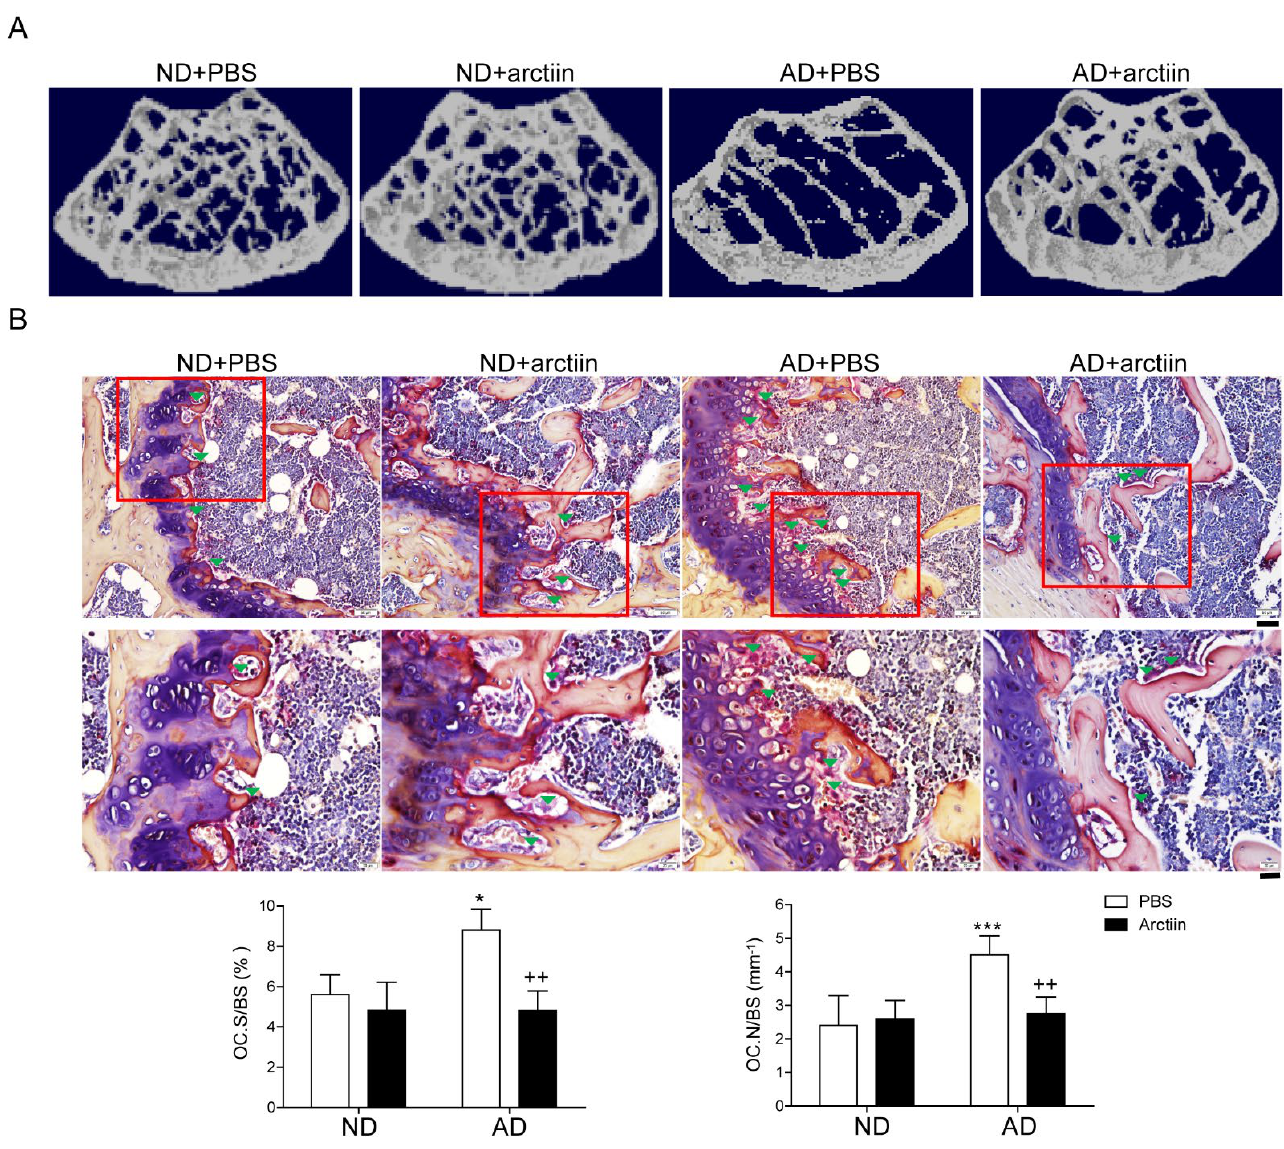
Figure 1. Arctiin protects mice from atherogenic diet-induced bone loss. ( A ) Representative µ CT images of distal mouse femora area (1.7 mm) located 0.4 mm below the distal femur growth plate in mice fed with ND + PBS ( n = 5), ND + arctiin (10 mg/kg/d, n = 5), AD + PBS ( n = 5), or AD + arctiin (10 mg/kg/d, n = 5) for 6 weeks. ( B ) Representative histologic sections of the distal femoral metaphysis of each group were stained for TRAP to calculate the OC.N/BS (OC number over total bone surface) and OC.S/BS (OC surface over total bone surface) ratios (original magnification × 200 (top) and × 400 (bottom)). Scale bar: × 200 (50 µ m), × 400 (20 µ m) in representative photos. * p < 0.05; *** p < 0.001 compared with the corresponding ND group. ++ p < 0.01 compared with the corresponding AD group. Differences between groups were analyzed via two-way ANOVA followed by Bonferroni post hoc tests. Similar results were obtained in three independent sets of experiments and µ CT analysis was performed with a representative set.